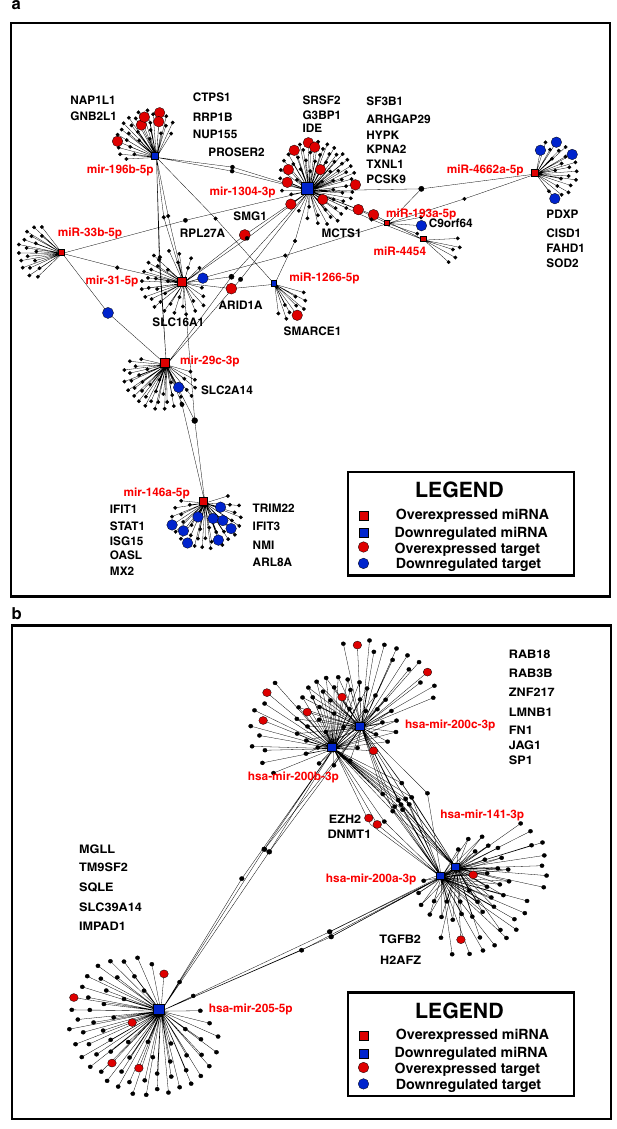
Figure 4. miRNA-mRNA interaction network of significantly dysregulated miRNAs and their targets in ( a ) OKF6/TERT1-Tobacco cells ( b ) OKF6/TERT1-Smoke cells. Square blocks represent dysregulated miRNAs and circles represent their target proteins showing inverse correlation. Overexpressed miRNAs and proteins are highlighted in red while downregulated miRNAs and proteins are highlighted in blue